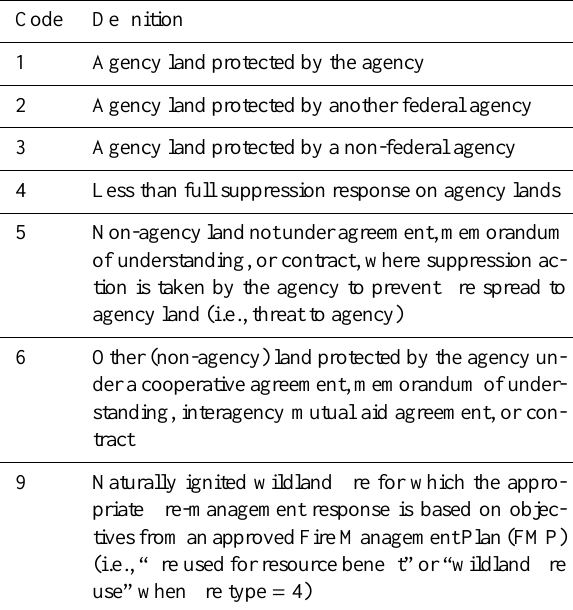
Table 3. Fire cause codes and definitions, adapted from USFS (2003).